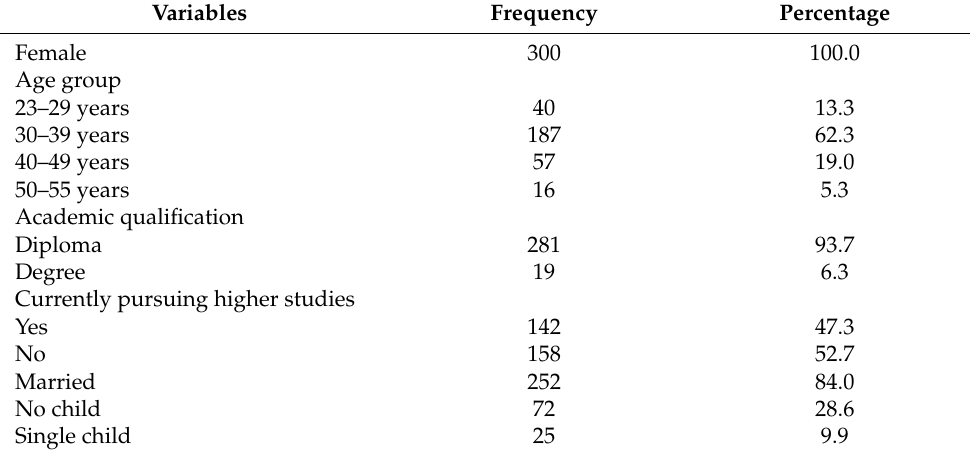
Table 1. Socio-demographic